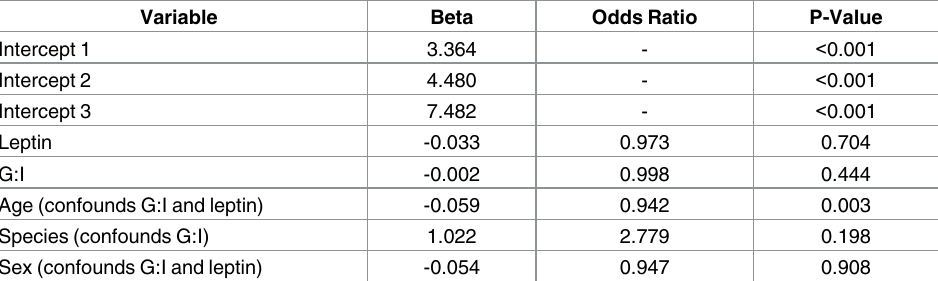
Table 7. Leptin and the glucose-to-insulin ratio (G:I) in predicting musculoskeletal health using multi- nomial logistic